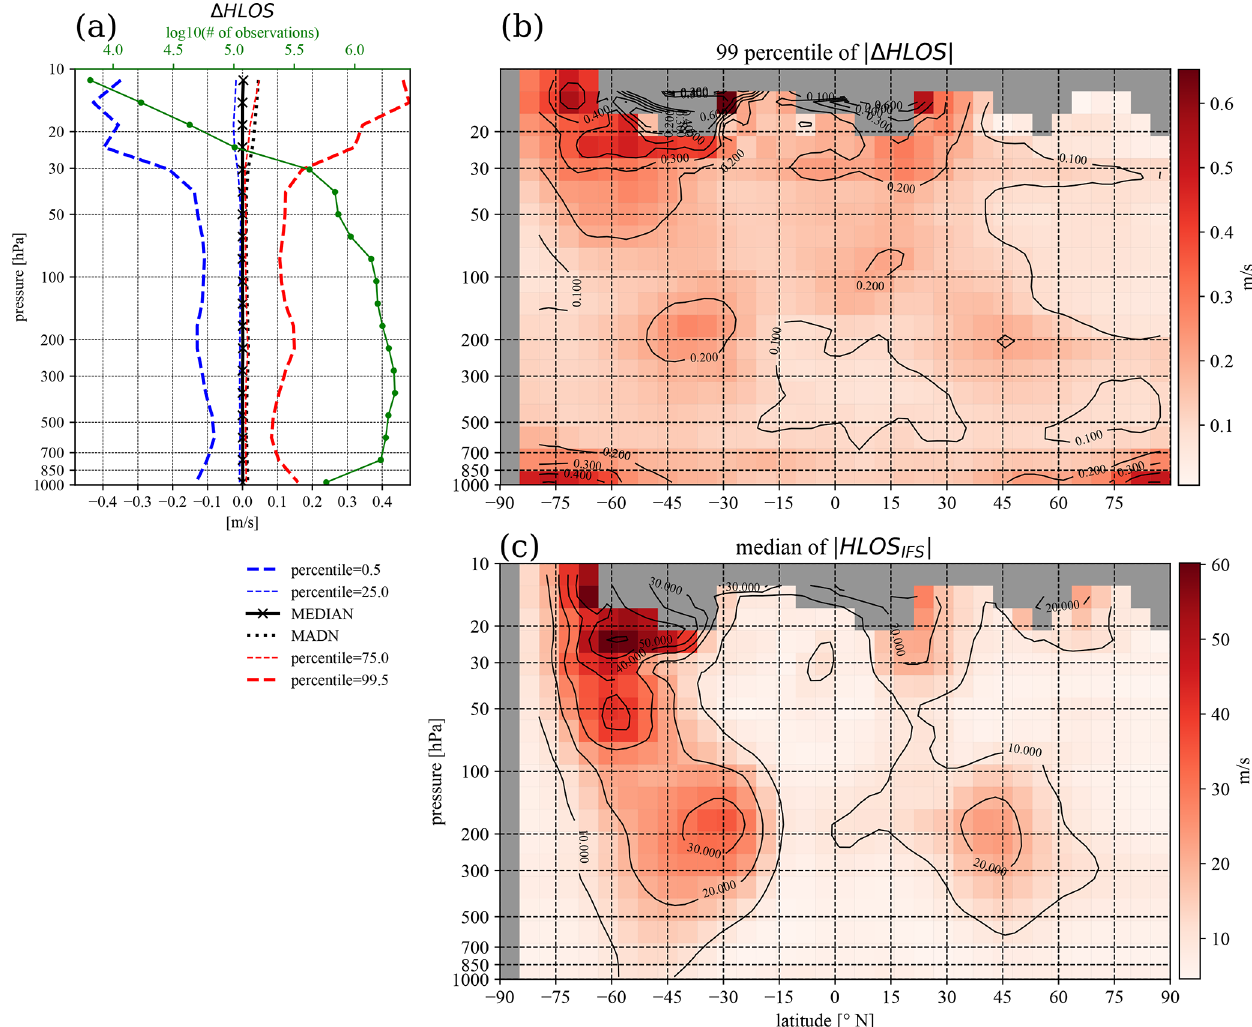
Figure 7. The (cid:49) HLOS statistics related to the dataset presented in Figs. 3–5 and computed by Eq. (3). (a) The spatial and temporal statistics are displayed as a function of pressure showing the median, madn and several percentiles. The number of available data at specific pressure layers (solid green). (b) The 99th percentile of | (cid:49) HLOS | and (c) the median of the | HLOS ecmwf | from the operational L2B output